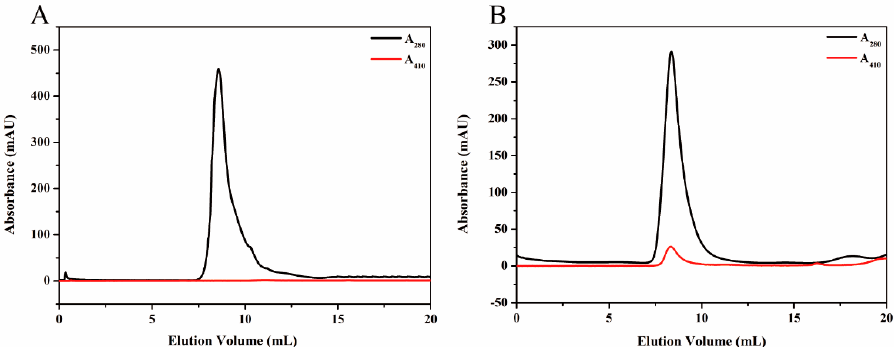
Figure 3. SEC of HE ( A ) before mineralization reaction and ( B ) after mineralization. The black lines represent the protein absorption at 280 nm and the red lines represent the iron oxide mineral absorption at 410 nm.